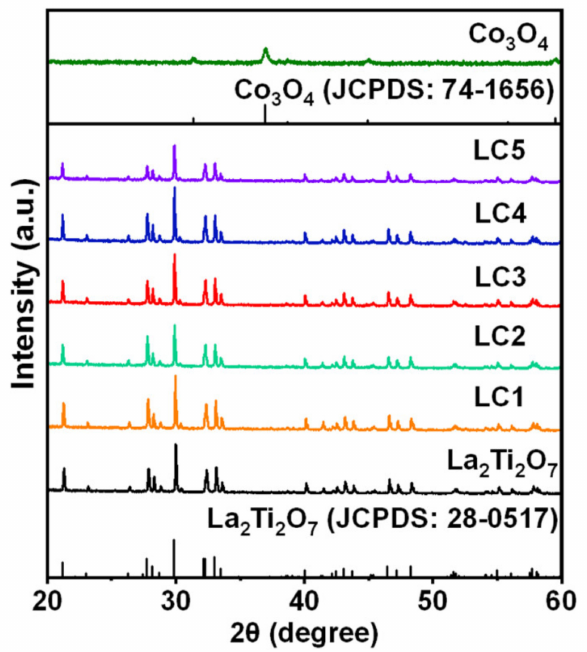
Figure 1. XRD patterns of La 2 Ti 2 O 7 , Co 3 O 4 and Co 3 O 4 /La 2 Ti 2 O 7 composites.